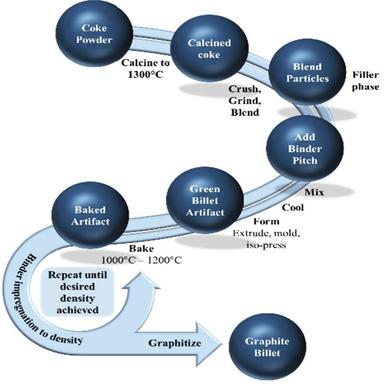
Typical process steps in the manufacture of nuclear graphite.